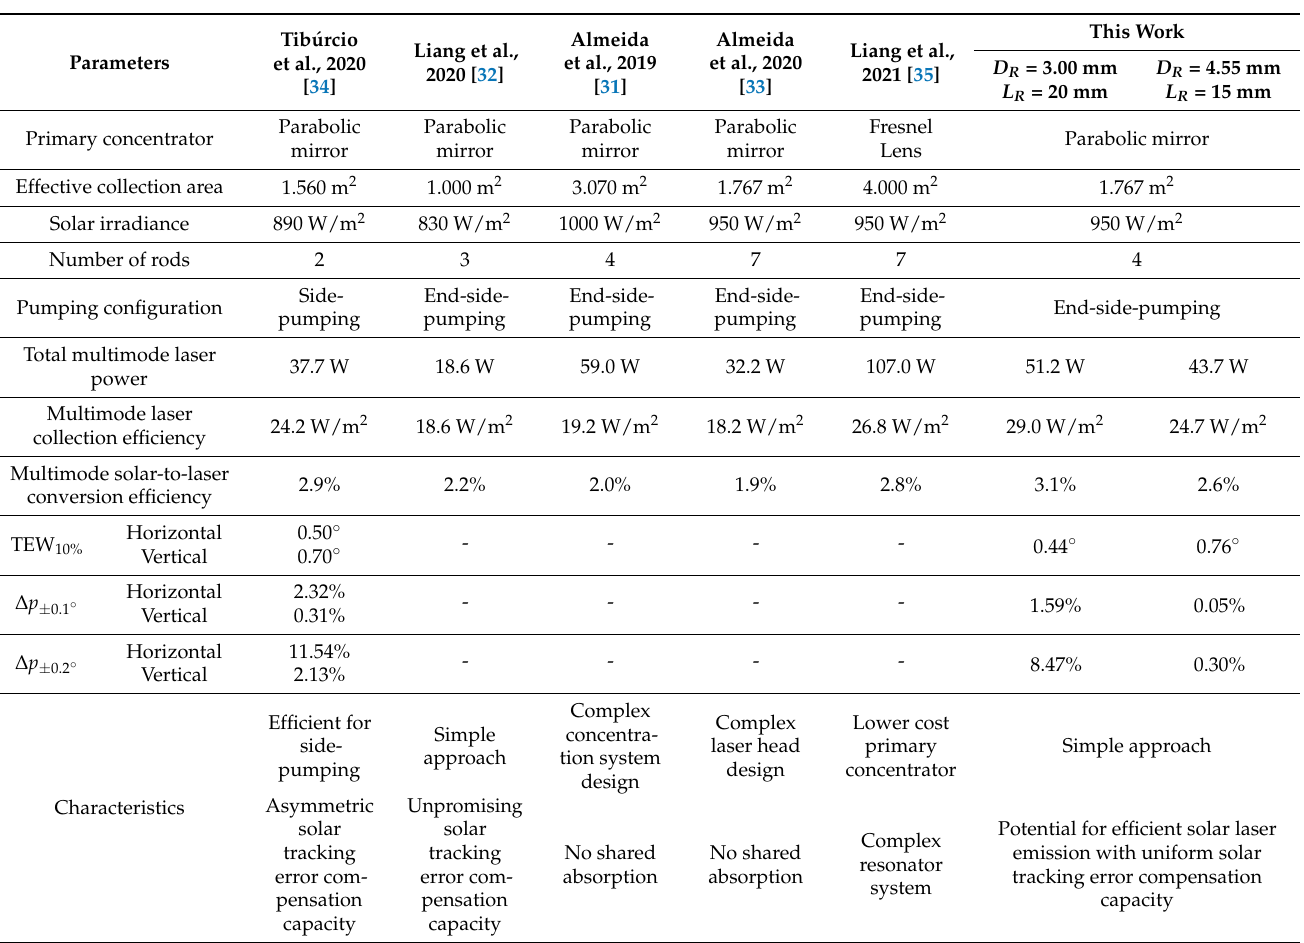
Table 2. Recent numerical progress on multi-rod solar laser performance using Nd:YAG laser